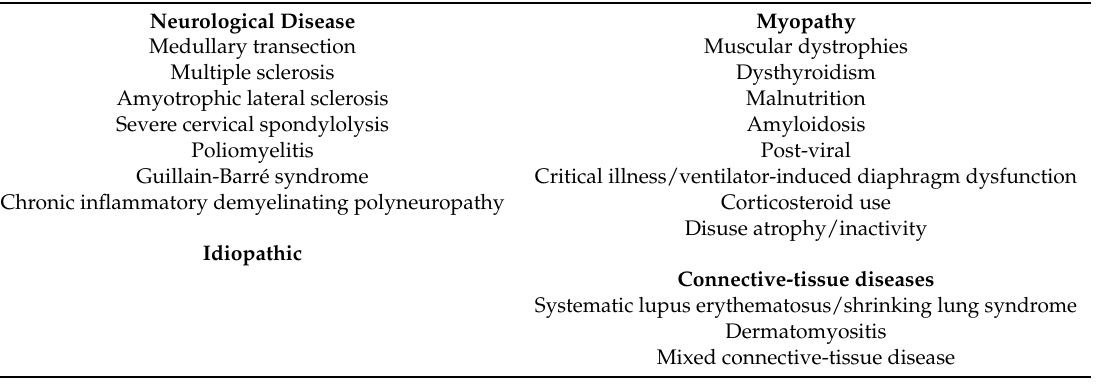
Table 3. Principal causes of bilateral diaphragm weakness (partial or complete loss of